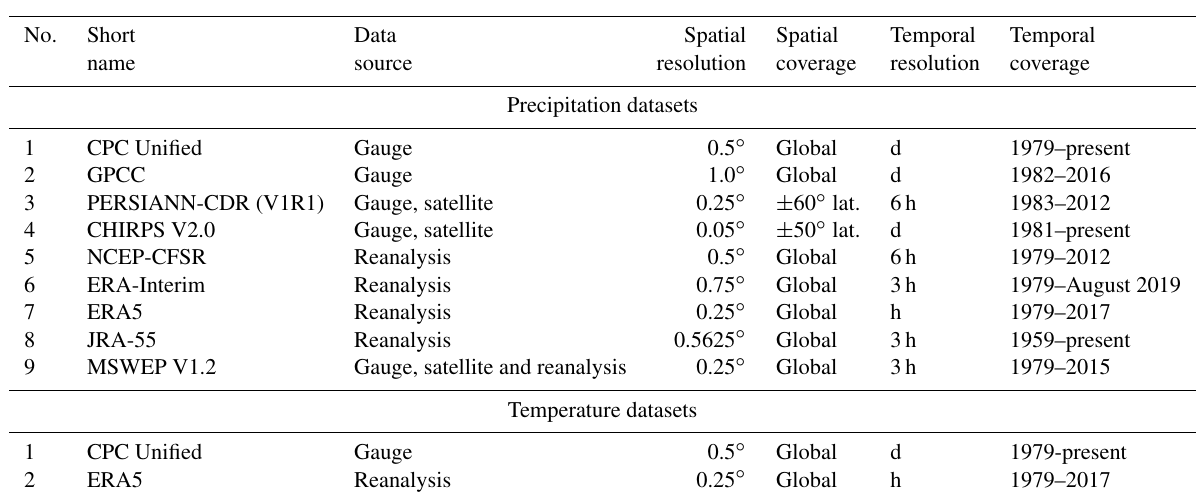
Table 2. The selected global gridded datasets.